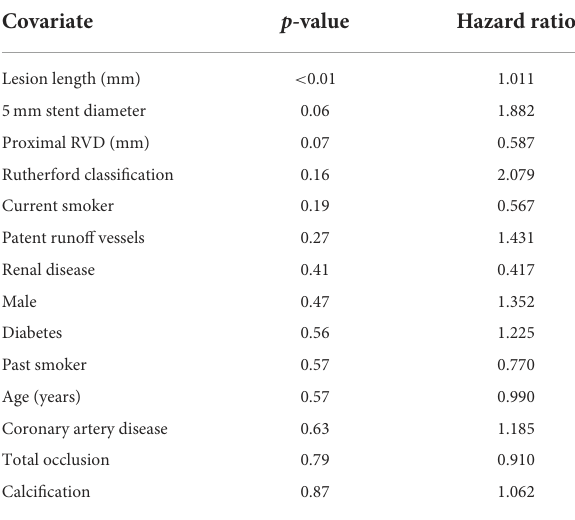
TABLE 4 Patency covariate